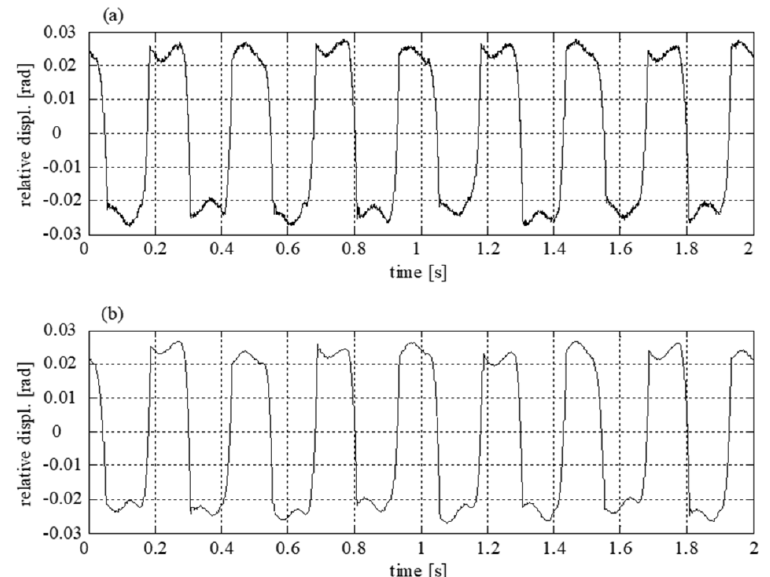
Figure 3. An example of theoretical–experimental correlation for time histories under gear rattle conditions ( ω = 600 rpm; ∆ ω = 100 rpm; f = 4 Hz; ( a ) experimental; ( b )